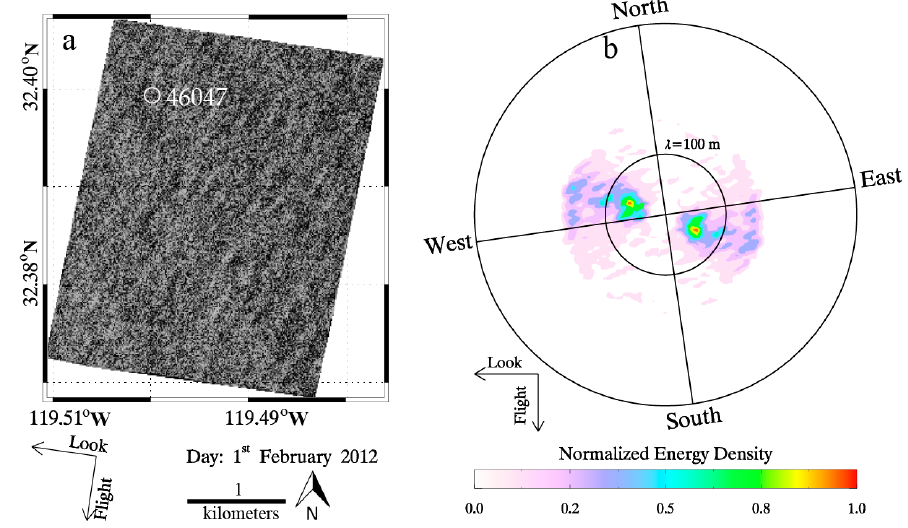
Figure 7. ( a ) Intensity image of sub-scene covering the NOAA in situ buoy (ID: 46047); and ( b ) the two-dimensional SAR spectrum in term of length λ corresponding to the sub-scene.